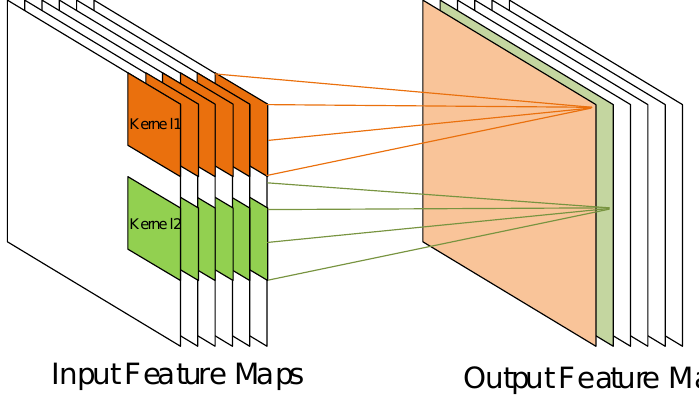
Figure 2. Input and output feature maps of a convolutional